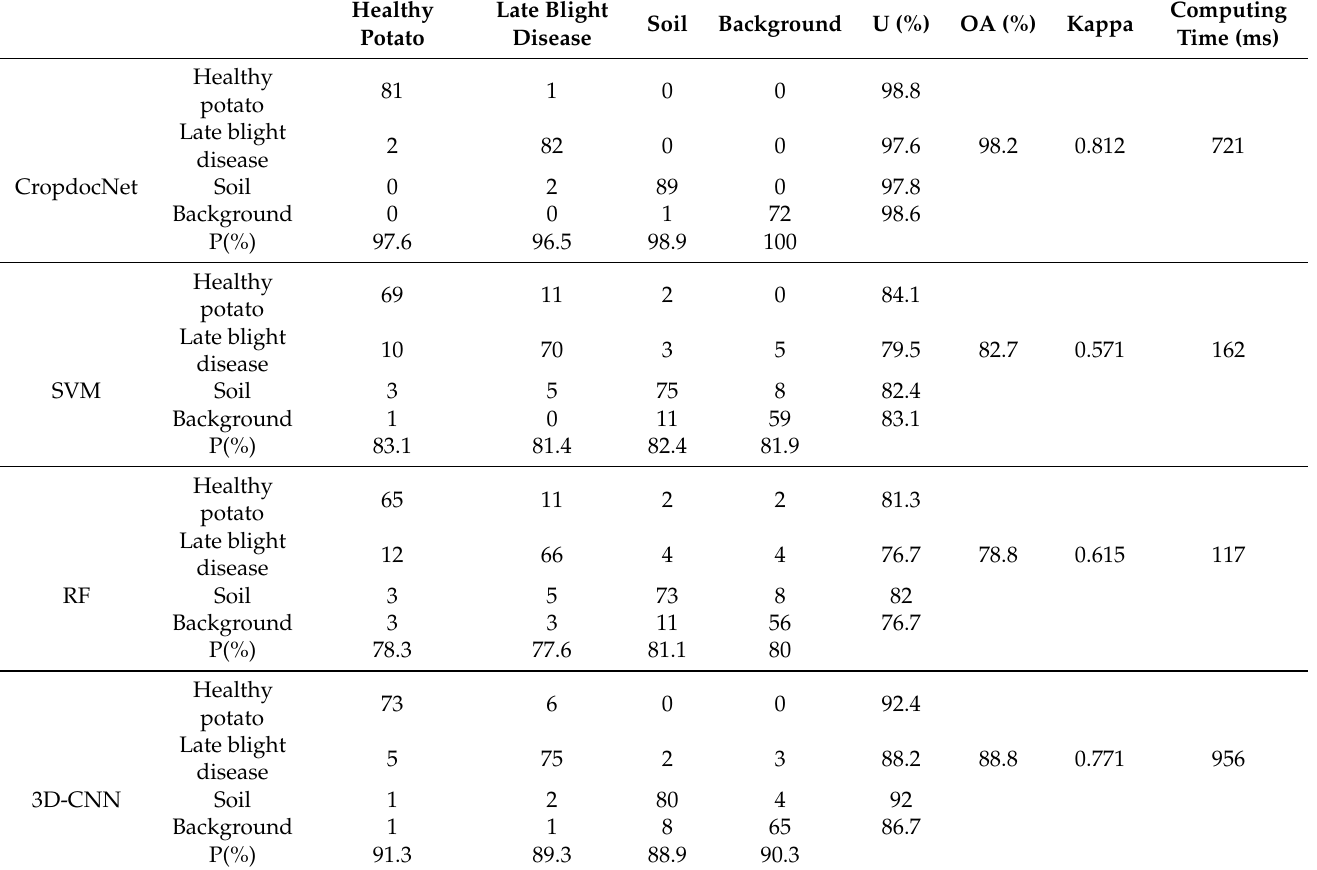
Table 5. The confusion matrix of the proposed model and the existing models on the pixel-scale detection of potato late blight disease. Here, UA is the user’s accuracy, PA is the producer’s